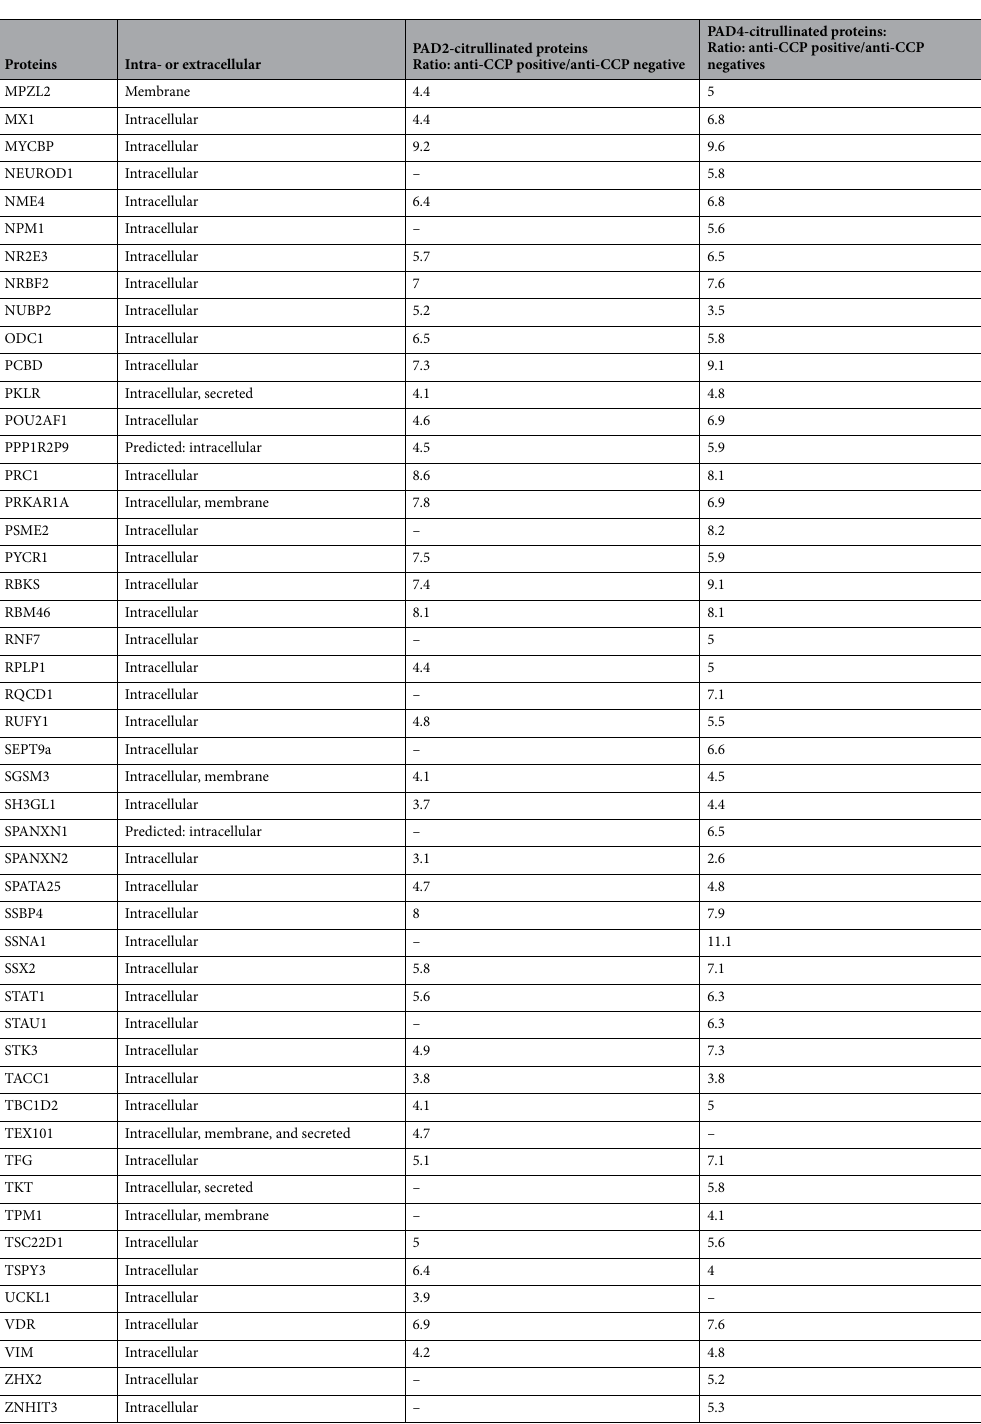
Table 2. Citrullinated autoantigens targeted by autoantibodies. Results are listed as fold differences calculated from the relative fluorescence unit value and are statistically significant. Requirements for inclusion in the table were Z-score > 2, CV < 15, CI-P < 0.05, fold difference > 2, and a BH corrected P value < 0.05. ALDOA fructose- biphosphate aldolase A, ILF2 interleukin enhancer-binding factor 2, KRT15 keratin, type I cytoskeletal 15,